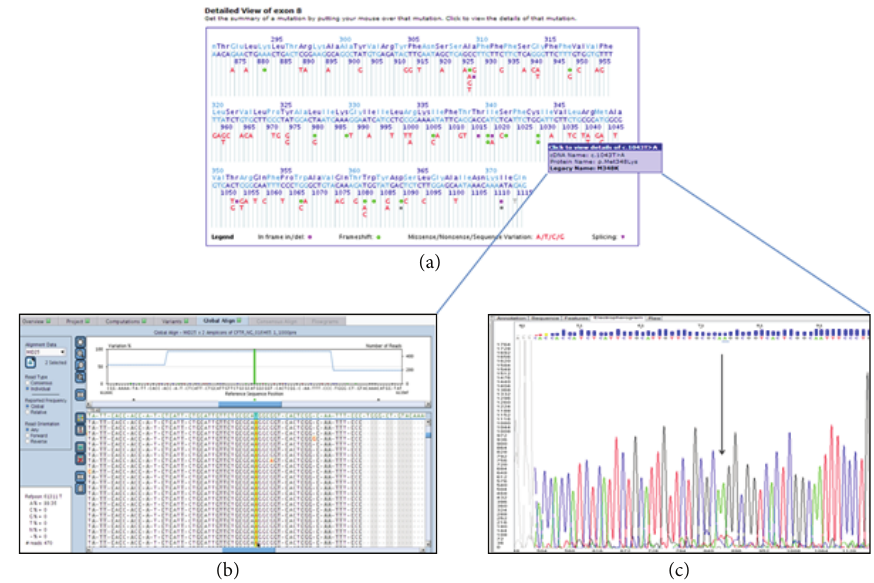
Figure1:(a)SequencereferencebyCysticFibrosisMutationDatabase(http://www.genet.sickkids.on.ca/app).(b)AmpliconVariantAnalyzer v 2.7 (AVA) aligns the sequencing reads to the reference sequences NG 016465.1 for CFTR gene (Reads = 470; % A = 99.36%). (c) Sequencing electropherograms of patient showing the substitution of T to A at nucleotide 1043 at exon 8 (the arrow indicates the mutant nucleotide).